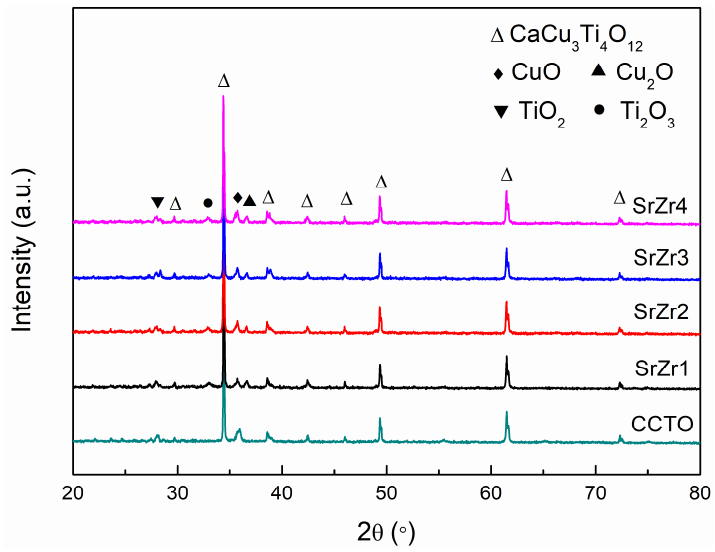
Figure 1. XRD patterns obtained for the as-prepared CCTO, SrZr1, SrZr2, SrZr3, and SrZr4 ceramics. Table 1. Structure parameters of the pure CaCu 3 Ti 4 O 12 (CCTO) and Sr–Zr co-doped